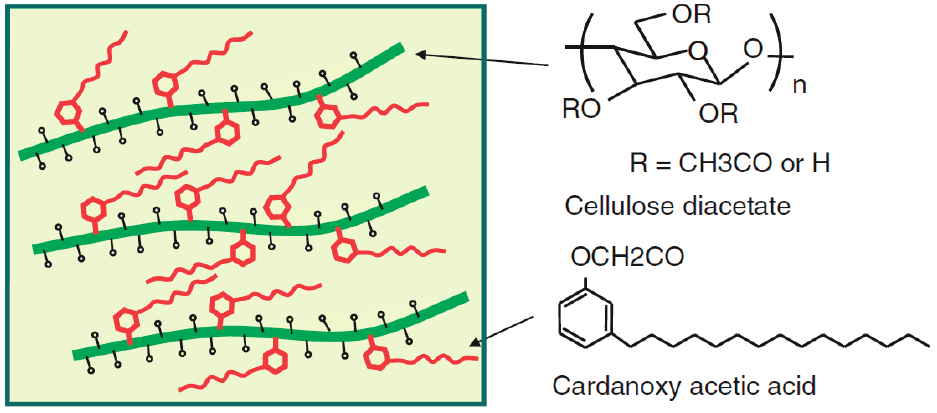
Figure 7. Hypothetical structure of cardanol-bonded CDA. Reproduced with permission from ref. [26]. Copyright 2011 The Society of Polymer Science, Japan